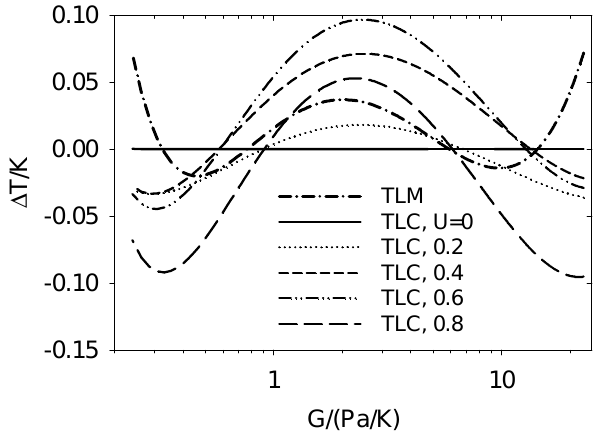
Fig. A3. Threshold temperature T LC versus liquid relative humidity for 5 values of G , equidistant within (0.24–23)PaK − 1 , increasing from bottom to